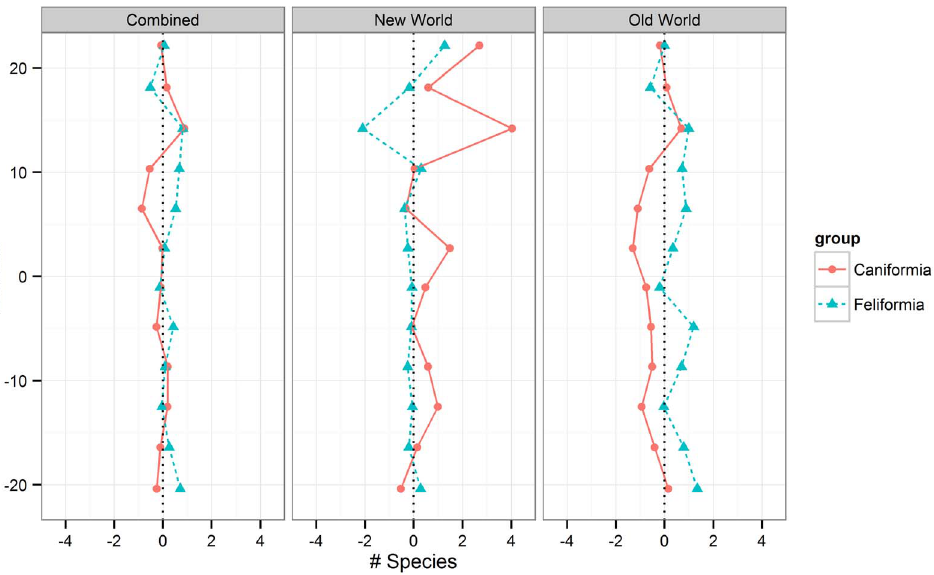
Figure 5. The residual number of species per cell of the spatial auto-regressive error (SAR) models of the clade species richness against the environmental predictors. Plotted against a latitudinal gradient for both the Caniformia and Feliformia models run on all environmental predictors.